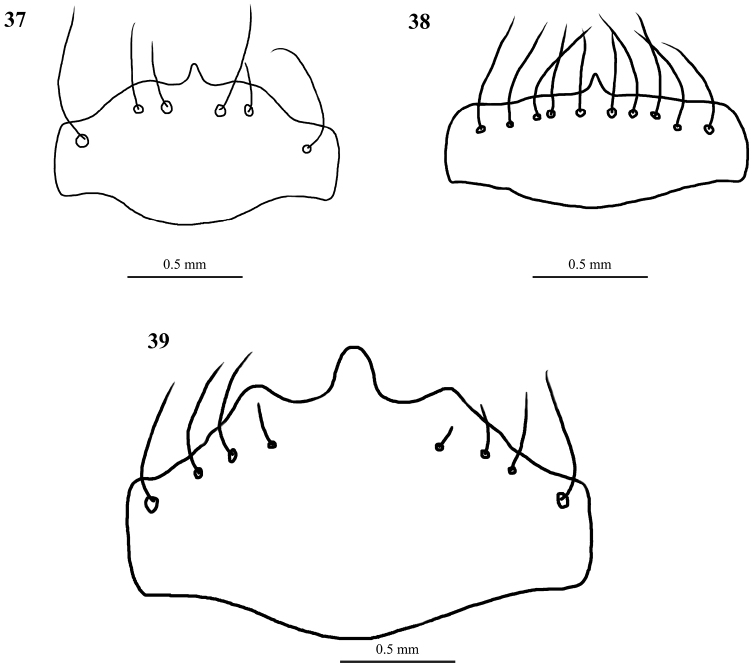
Line drawings of labra of Taiwanese Cylindera (female) 37C.
kaleea38C.
elisae
reductelineata39C.
shirakii.